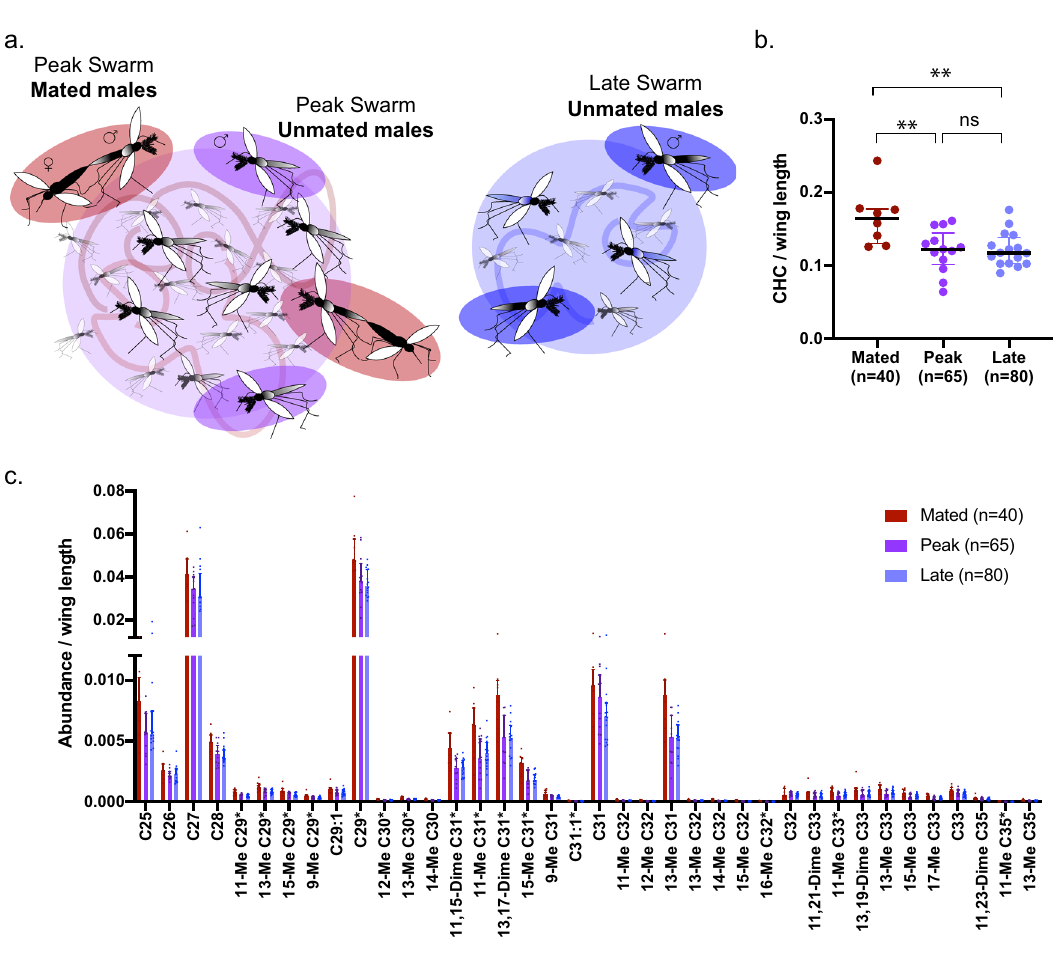
Fig. 1 Successful A. coluzzii males in natural swarms have higher abundance of CHCs. a Scheme of captures of male groups from mating swarms, showing mated males (left image, red), unmated males from the peak swarm (left image, purple), and unmated males collected late in the swarm (right image, blue). b Total abundance of CHCs is higher in mated compared to unmated males when captured at either peak or late time points during the swarm (Tukey ’ s multiple comparisons, p = 0.0045 (mated vs peak unmated), p = 0.0041 (mated vs late unmated)). The mean sum of response ratios for all CHCs divided by the mean wing length for each sample is shown. Error bars represent SD, and n describes total number of mosquitoes. c Mated males have higher abundance of 15 of 38 CHCs compared to both unmated males captured at the peak or late time point detected by GC – MS, shown here as the median response ratio to a pentadecane internal standard and normalized to wing length. Nomenclature for each compound indicates position of methyl (Me) or Dimethyl (Dime) groups on the carbon chain. Error bars represent interquartile ranges; Benjamini – Hochberg corrected p values from Mann – Whitney tests are displayed in full in Supplementary Table 1. Asterisks are indicated next to names of compounds with statistically signi fi cant differences in both peak and late unmated groups compared to the mated